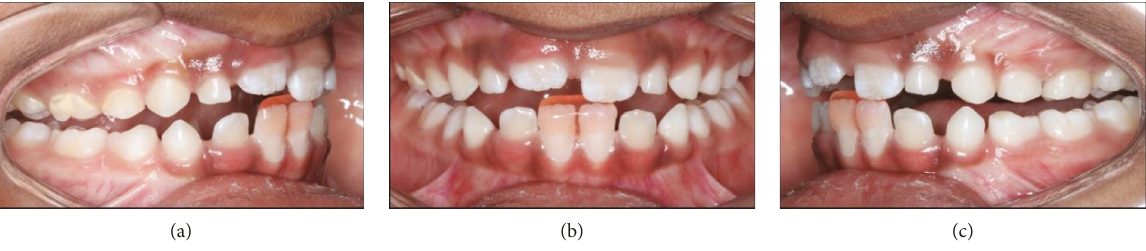
Figure 6: Progress records immediately after placing the functional turbo.